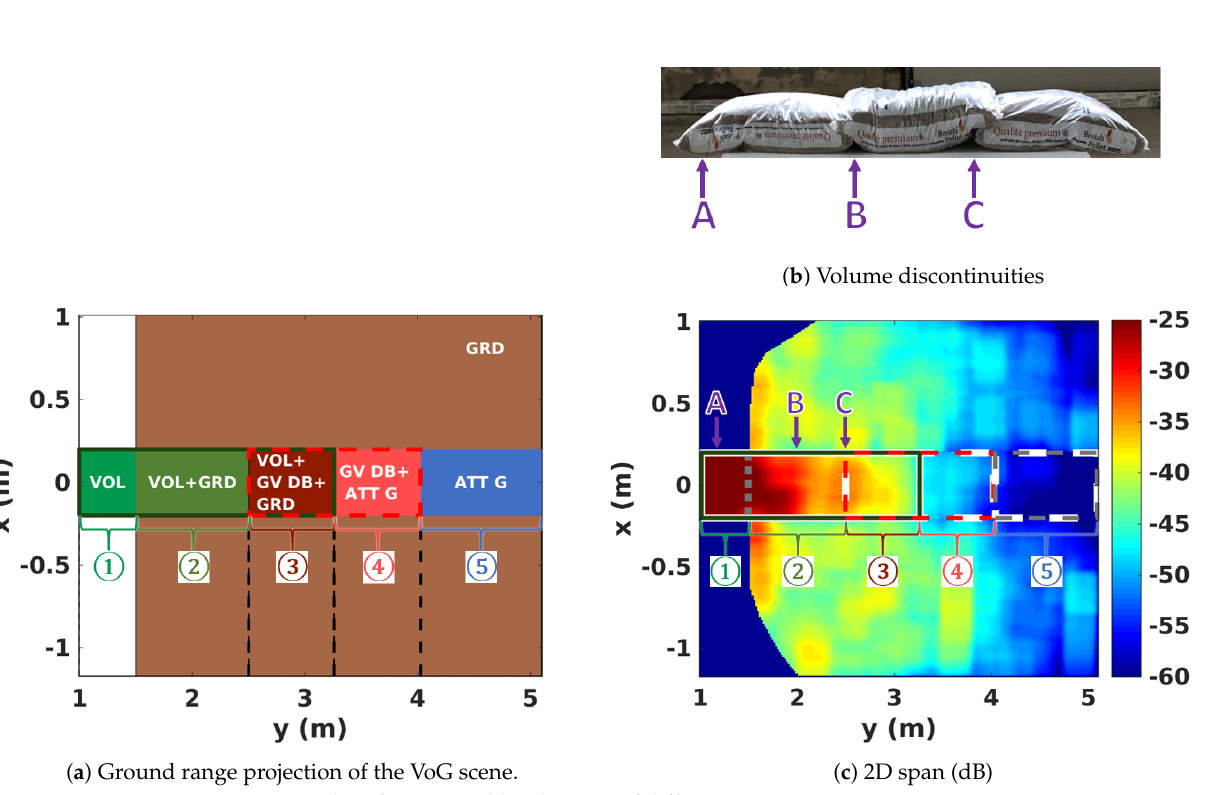
Figure 7. Identification and localization of different zones in a 2D SAR